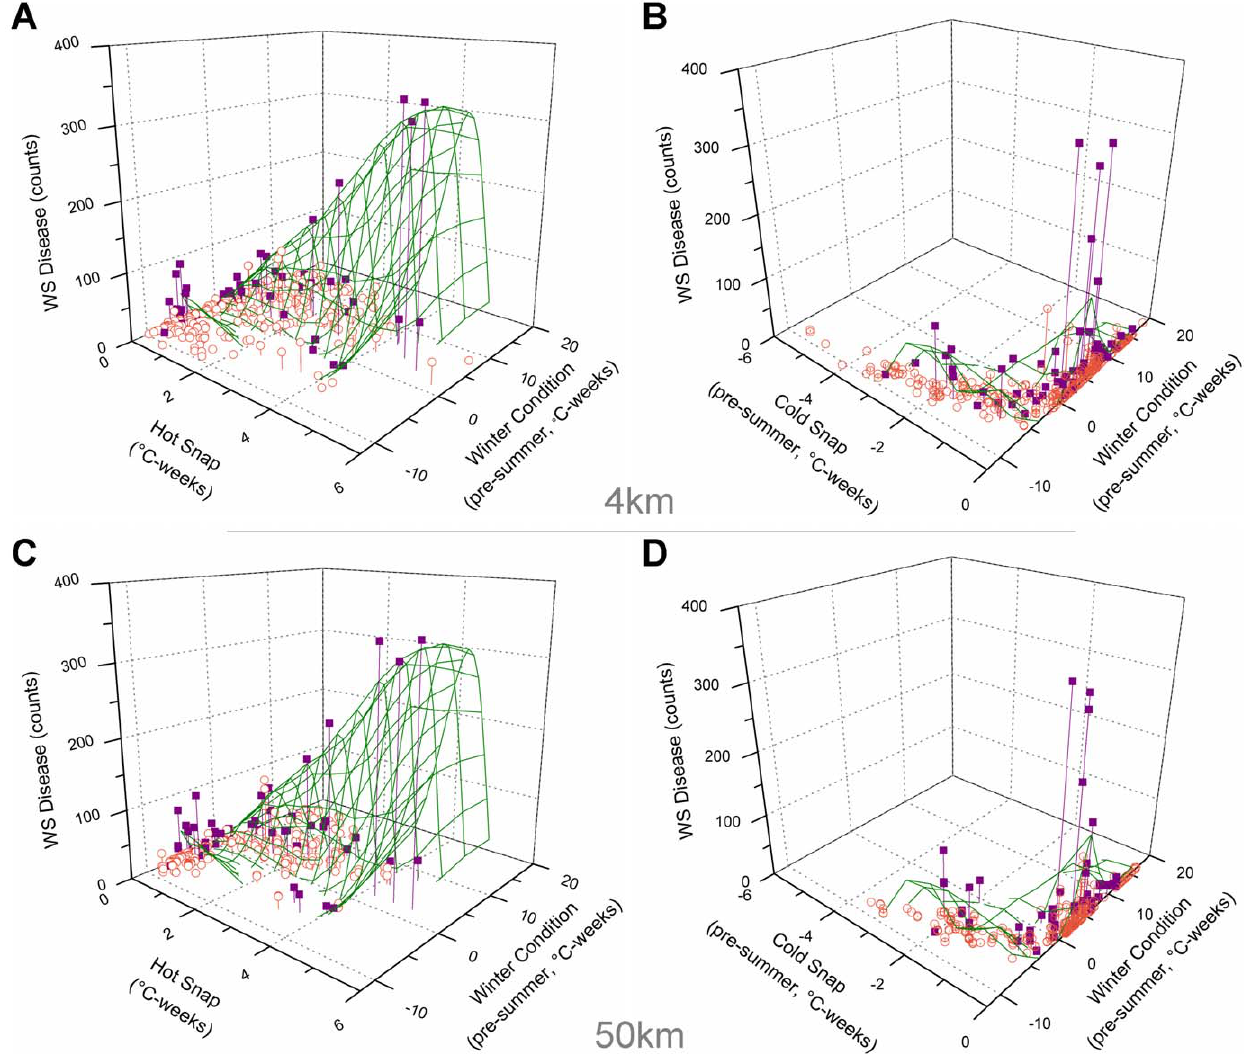
Figure 5. Observed disease counts plotted against satellite metrics. (a) 4 km summer-stress monitoring metrics; (b) 4 km post-winter seasonal forecast metrics; (c) 50 km summer-stress monitoring metrics; and (d) 50 km post-winter seasonal forecast metrics. Coral cover of Acropora spp. is indicated by open orange circles ( , 30%); and violet squares ( $ 30%).